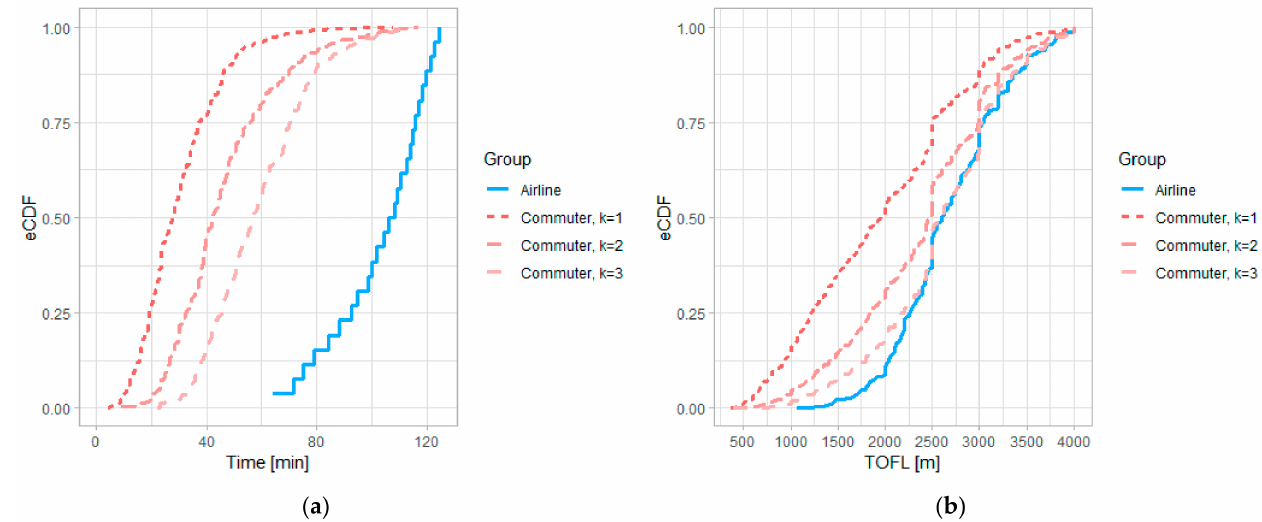
Figure 4. Ground infrastructure requirements of airports for airline services and the k-closest airfields for commuter air services: ( a ) accumulated distribution of the average time needed to reach the nearest airfield/airport (expressed as the mean time of first and mile transportation duration), and ( b ) accumulated distribution of available take-off field lengths.